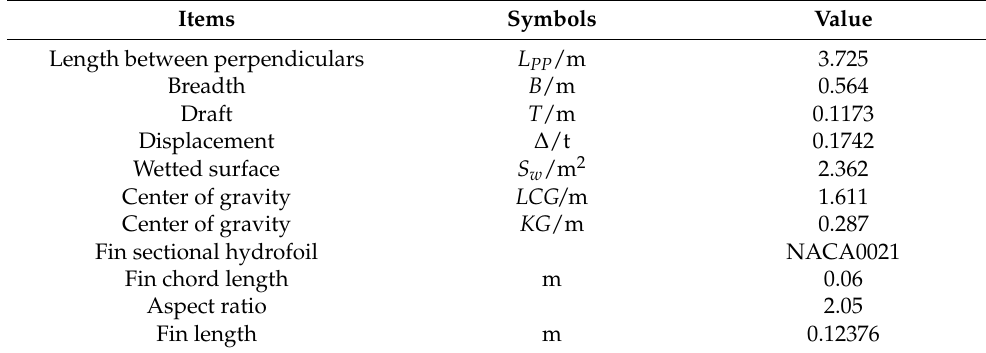
Table 1. Main parameters of the model.